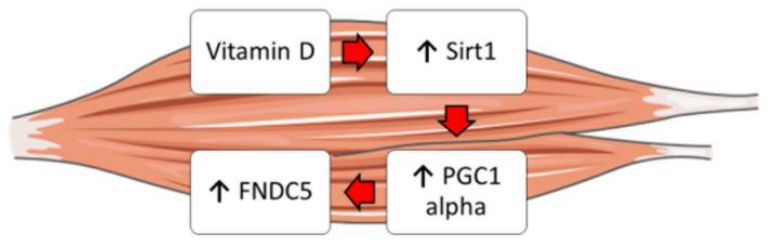
Figure 5. Schematic representation showing the possible effect of vitamin D on the Sirt1 > Pcg1a > Fndc5 pathway in skeletal muscle cells.